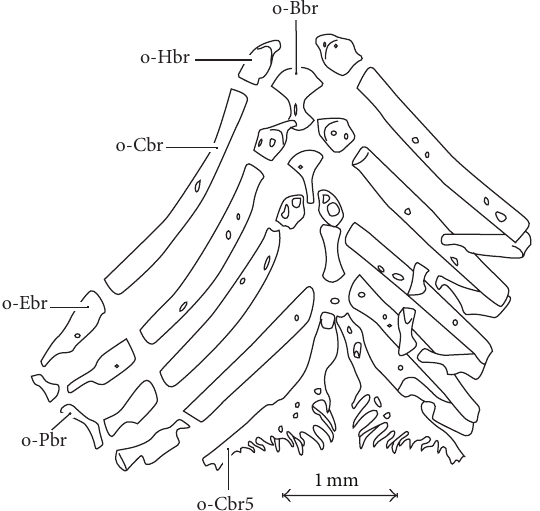
Figure4:Branchialapparatusof Oxynoemacheiluschomanicus .Bbr: basibranchial; Cbr: ceratobranchial (cbr5: pharyngeal bones); Ebr: epibranchial; Hbr: hypobranchial; Pbr: infrapharyngobranchials.